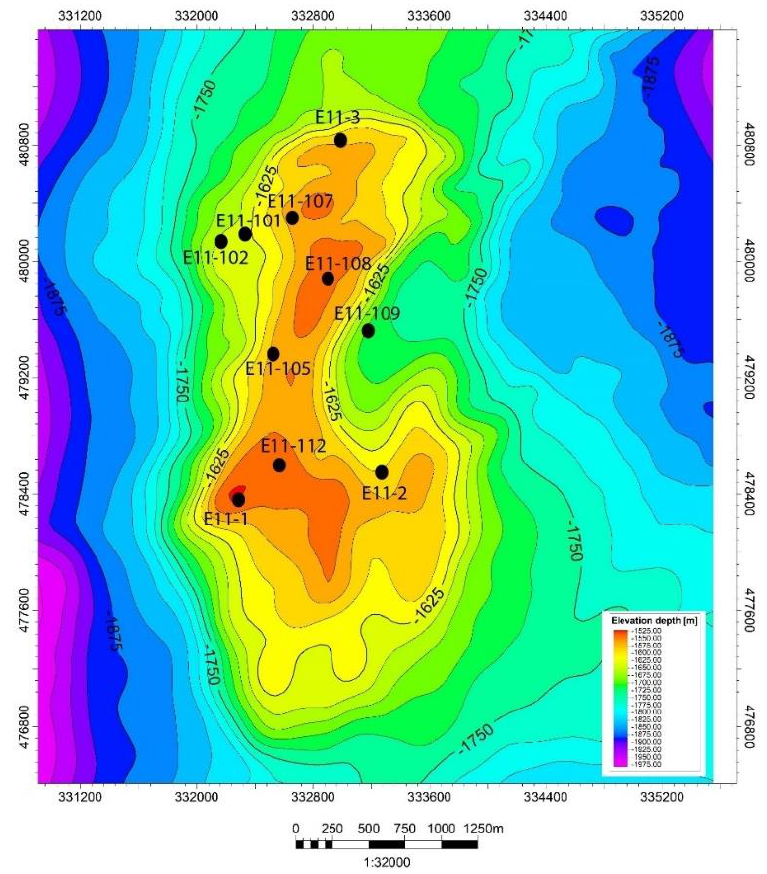
Figure 2. Base map of the carbonate map structure with the location of the 10 wells used for this study. Geomorphologically, the field consists of a lower megaplatform complex and an upper pinnacle stage (Figure